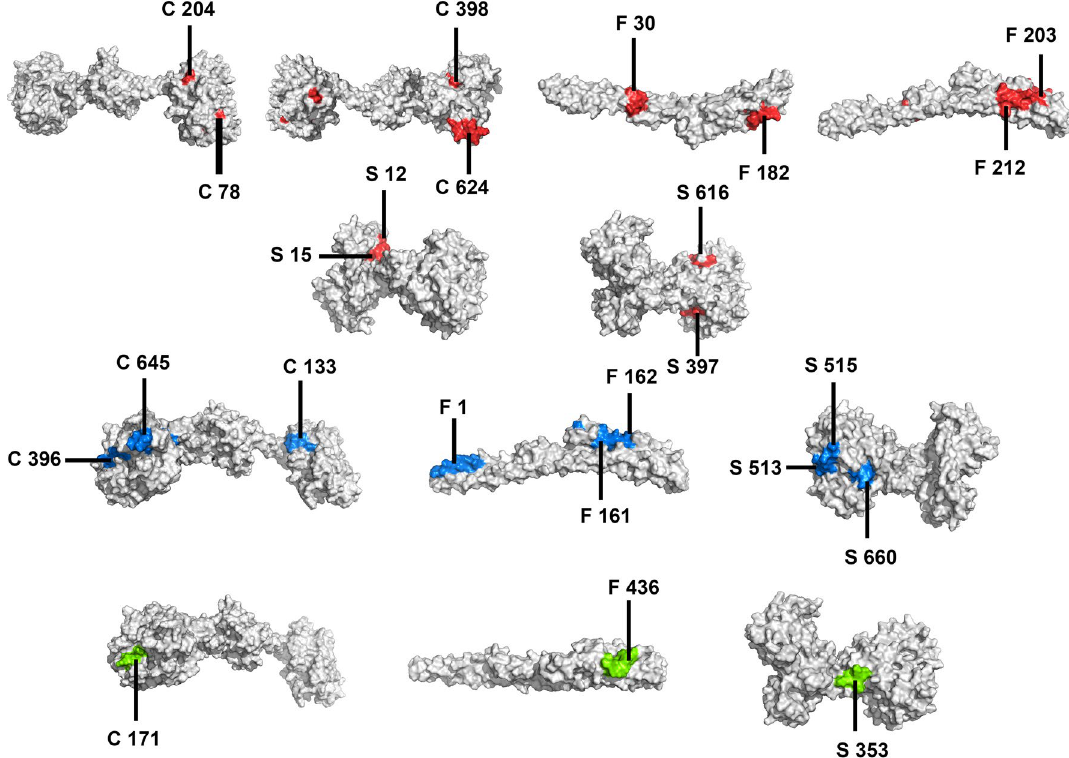
Figure 2. 3D structure of the CotE, FliC and SlpA proteins showing surface positions of CTL epitopes in red colour, HTL epitopes in blue colour and IFN-γ epitopes in green colour, where C denotes CotE, F denotes FliC and S denotes